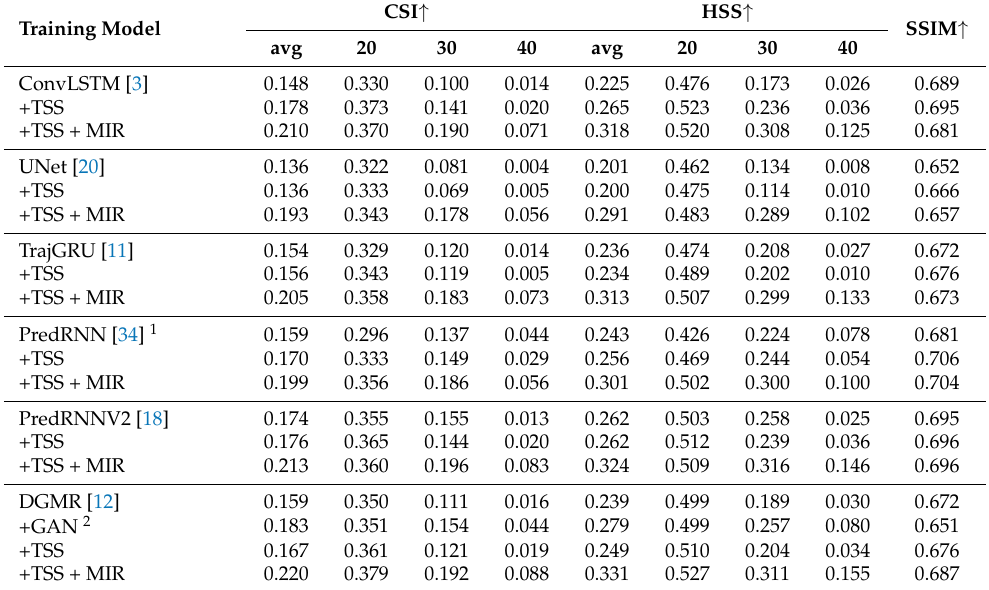
Table 4. Results of TSS and MIR on various models on the TAAS dataset. Training Model